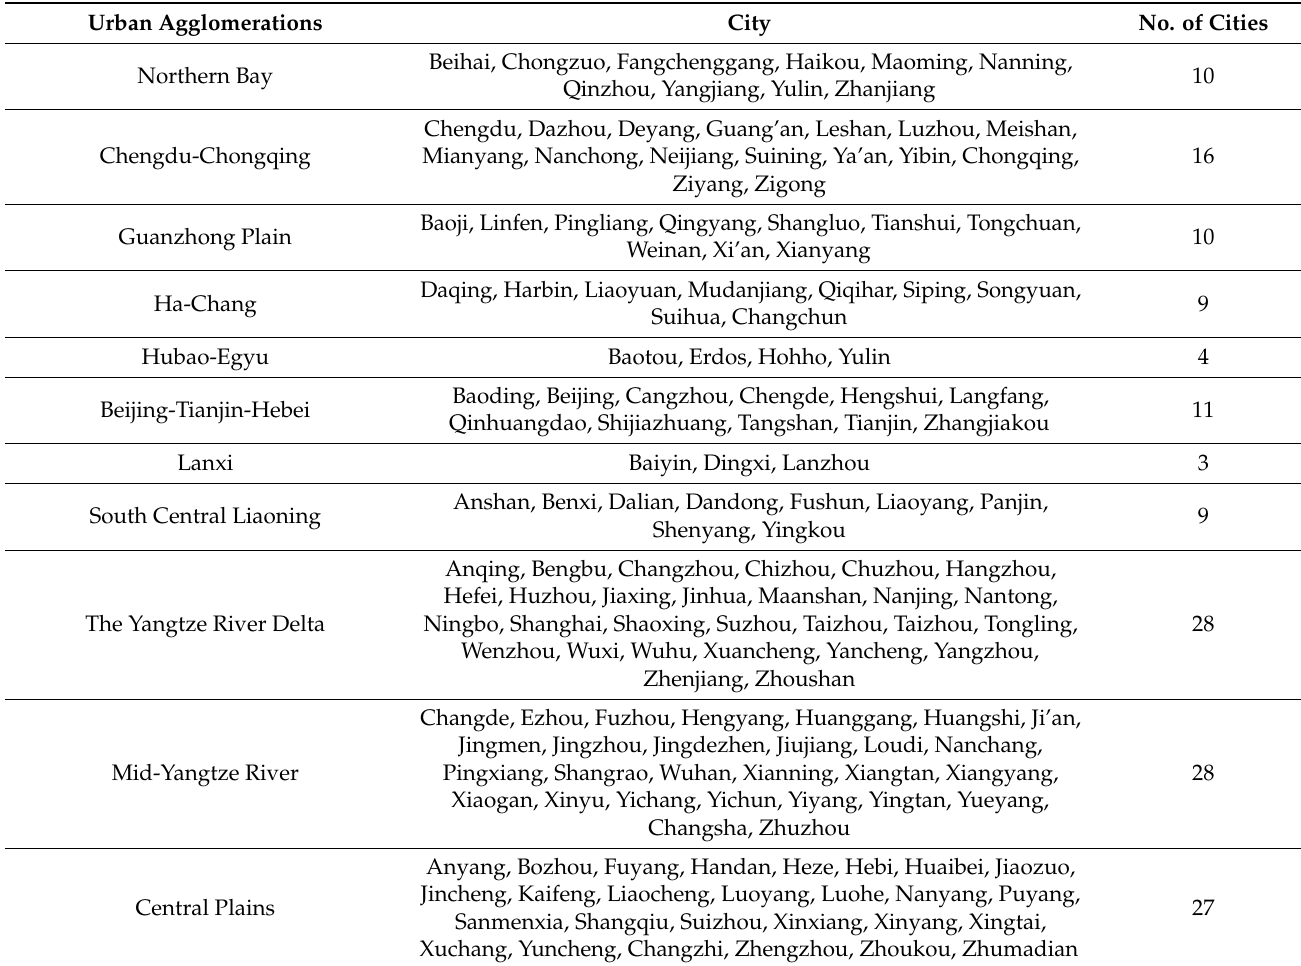
Table A1. The 155 cities in the NUA